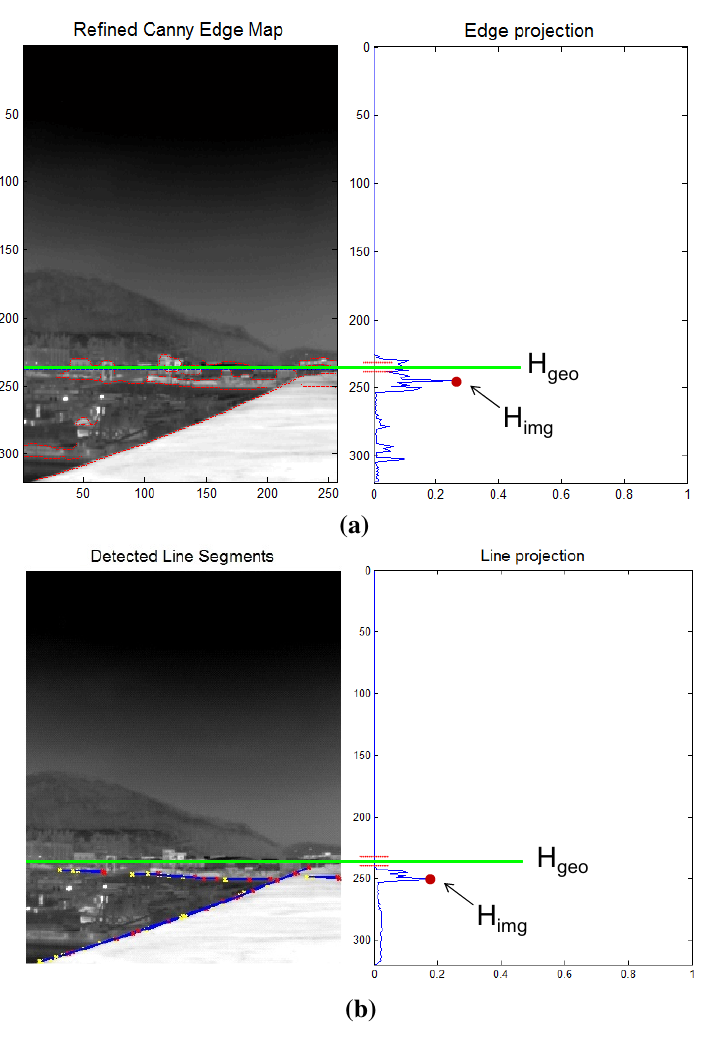
Figure 10. Estimation of the horizon in image ( H near coast region: ( a ) edge map-based measurement; ( b ) line map-based measurement.